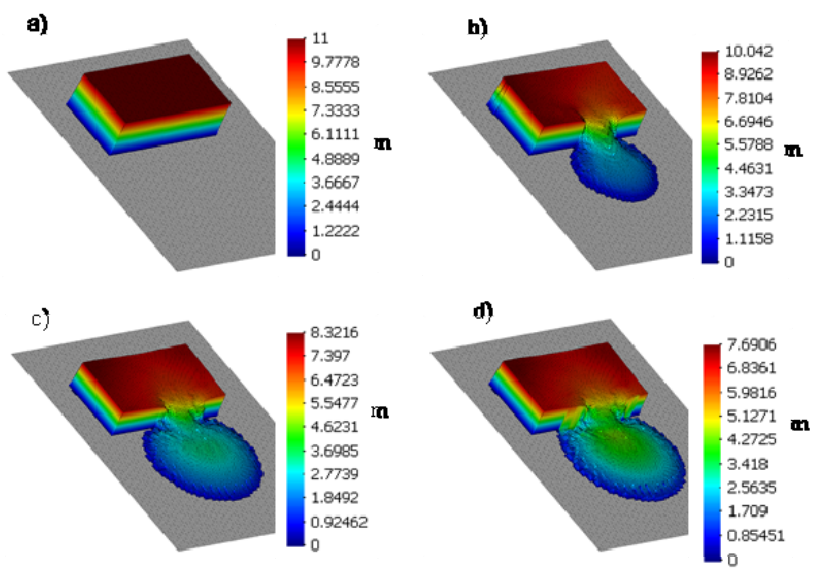
Figure 3. Soil height results of the analysis propagation of the tailings at a series of time stations. ( a ) t = 0 s; ( b ) t = 30 s; ( c ) t = 60 s and ( d ) t = 80 s.